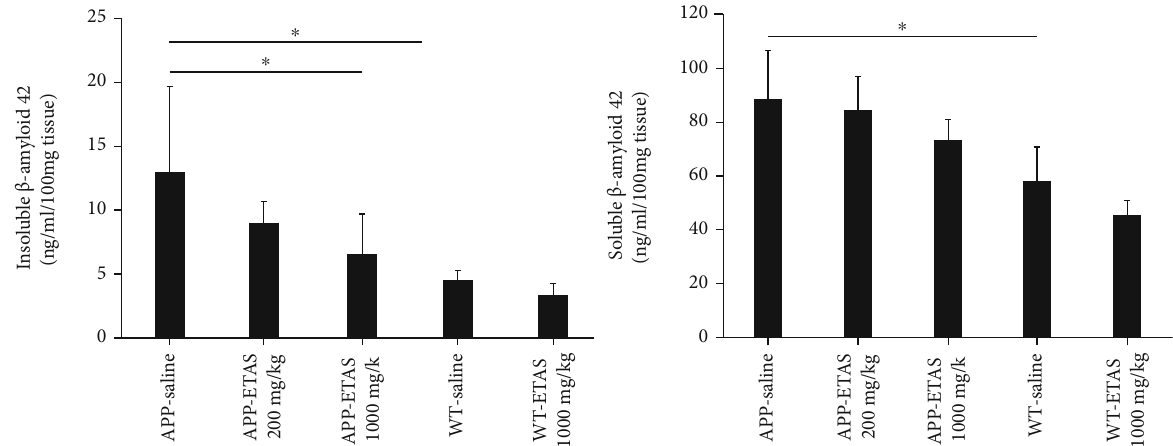
Figure 6: Quanti fi cation of soluble and insoluble β -amyloid using ELISA assay in the hippocampus in APP-overexpressed mice treated with ETAS (200mg/kg and 1000 mg/kg) and WT mice treated with ETAS (1000mg/kg) for 1 month, respectively. Insoluble: ∗ p < 0 : 05 WT saline vs. APP saline; APP-ETAS 200mg/kg vs. APP saline. Soluble: ∗ p < 0 : 05 WT saline vs. APP saline ( n = 5 mice in each